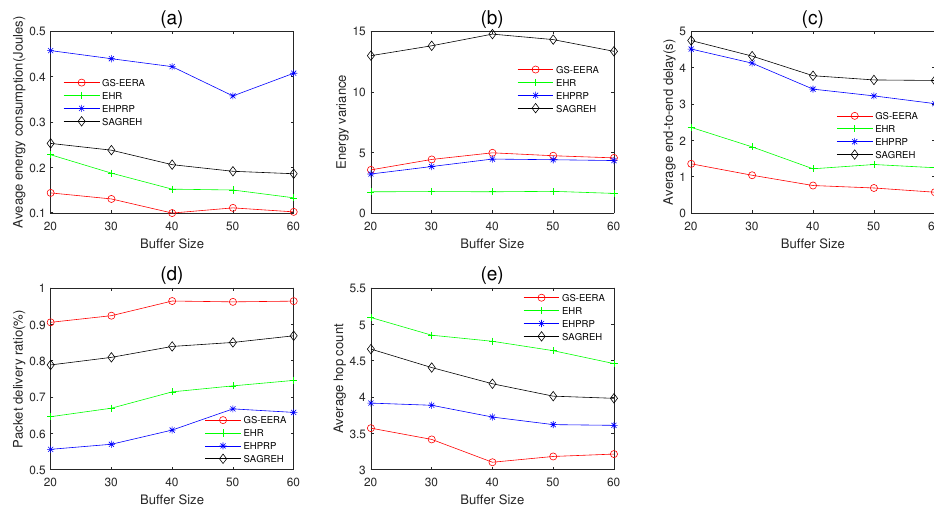
Figure 13. The impact of data buffer capacity on ( a ) average energy consumption, ( b ) energy variance, ( c ) average end-to-end delay, ( d ) packet delivery ratio and ( e ) average hop count.